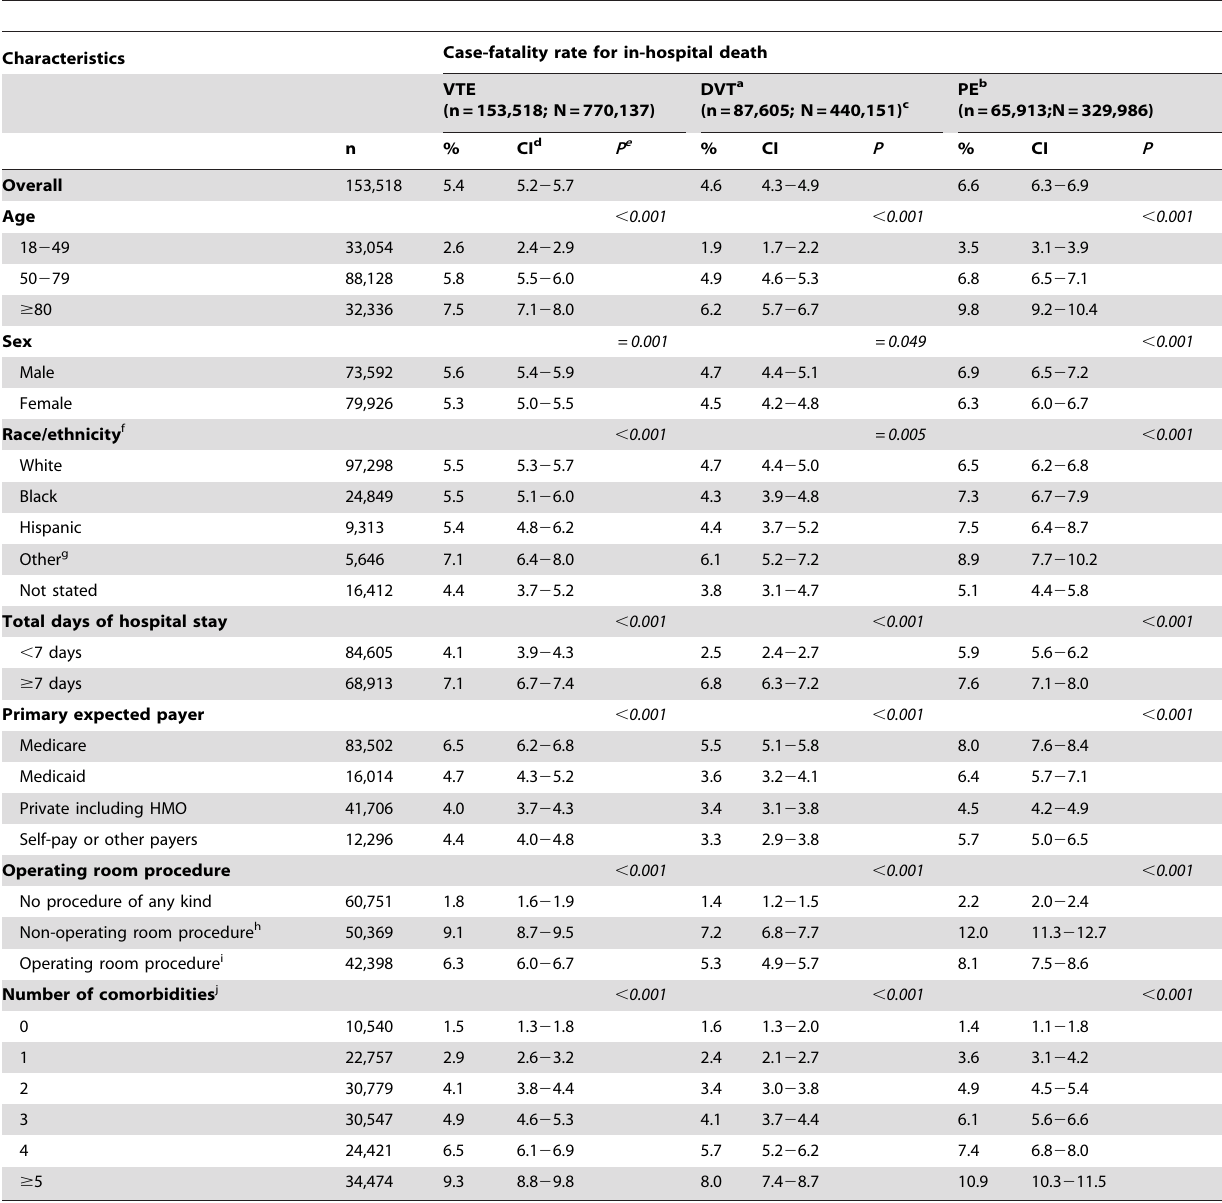
Table 1. Case-fatality rates for in-hospital death among adult hospitalizations with a diagnosis of VTE and among those with DVT or PE by demographic and clinical characteristics, NIS,